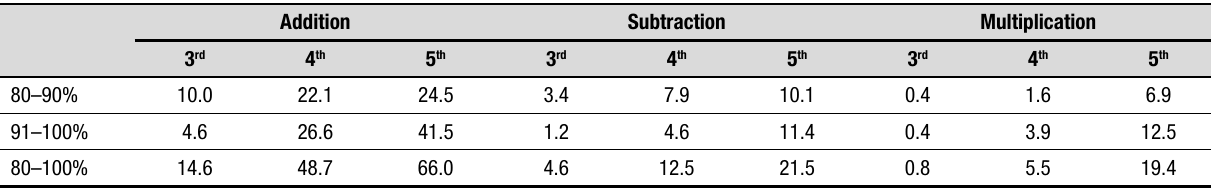
Table 1. Percentage of children scoring above 80% of correct responses on addition, subtraction, and multiplication operations at each grade.